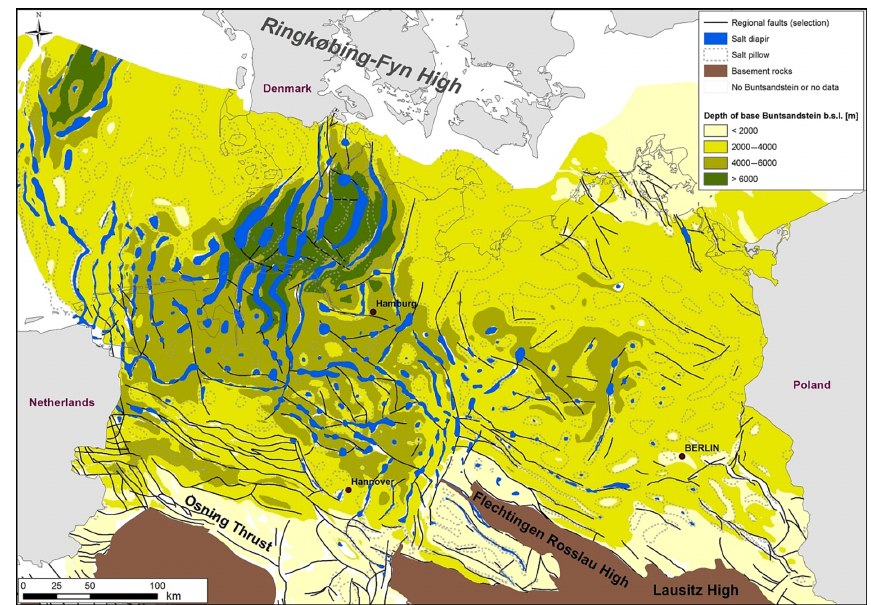
Figure 1. Extent and depth of the Buntsandstein group and important structural elements in the North German Basin (depicting data only for the German mainland and the German sectors of the North Sea and the Baltic Sea) based on (Reinhold et al., 2008), (Doornenbal and Stevenson, 2010), and (Schulz et al., 2013).